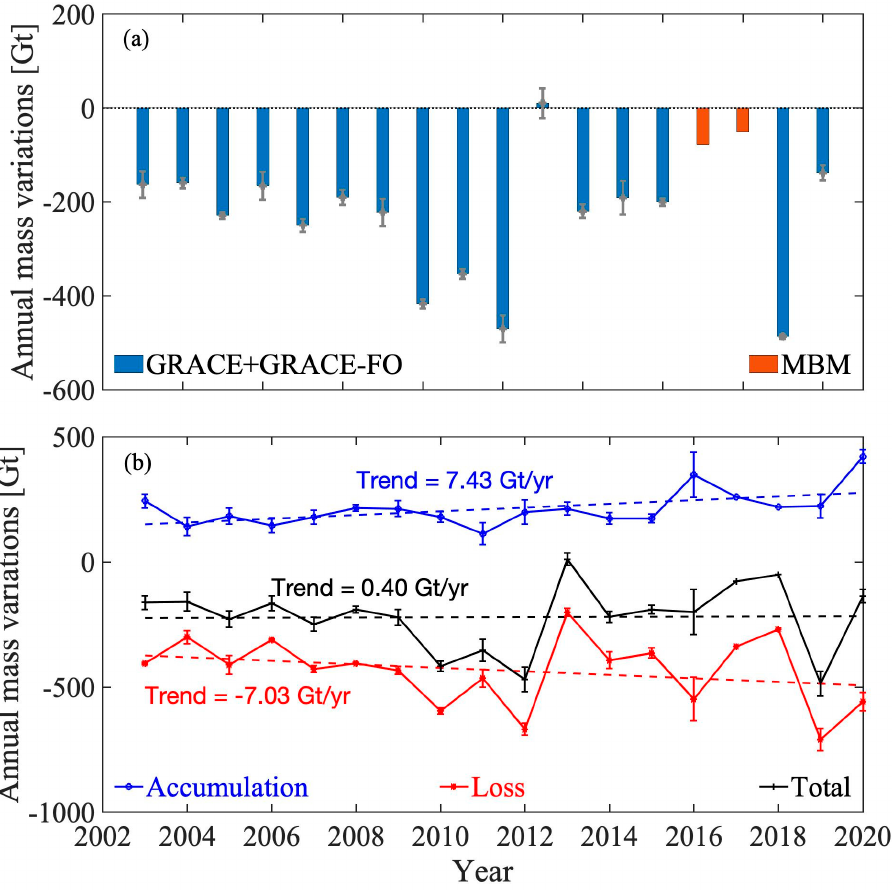
Figure 5. ( a ) Annual mass variations of the GrIS, with blue bars indicating those from GRACE/GRACE-FO and red bars those from the MBM. ( b ) Mass accumulation (blue dotted line), mass loss (red dotted line) at annual timescale and total annual mass change (black dotted line) of the GrIS.